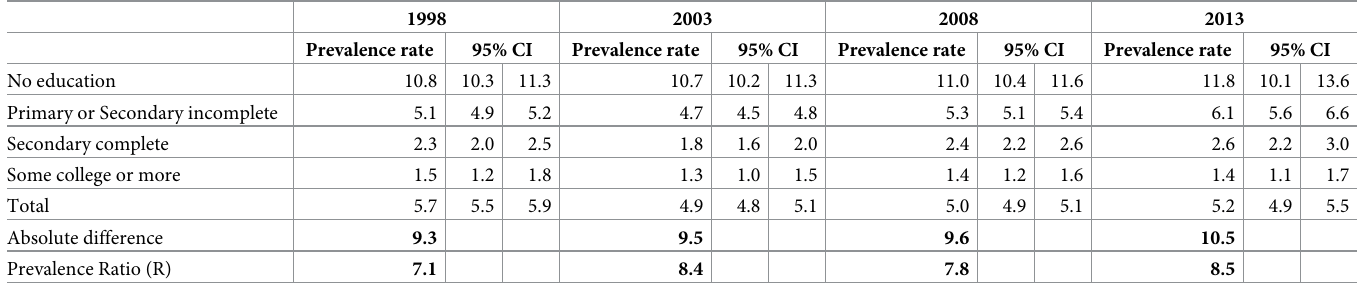
Table 2. Age-adjusted prevalence rates of poor self-rated health, Brazil: 1998–2013.